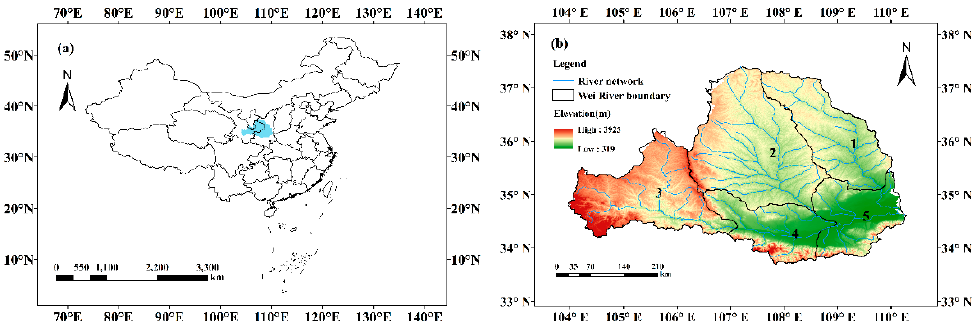
Figure 1. ( a ) Geographical location of the study area. ( b ) Elevation, river network and the sub-basins in the Wei River basin. The whole basin is divided into five sub-basins: 1. The Beiluo River; 2. The Jing River; 3. The upper reach of the Wei River basin; 4. The middle reach of the Wei River basin; and 5. The lower reach of the Wei River basin.